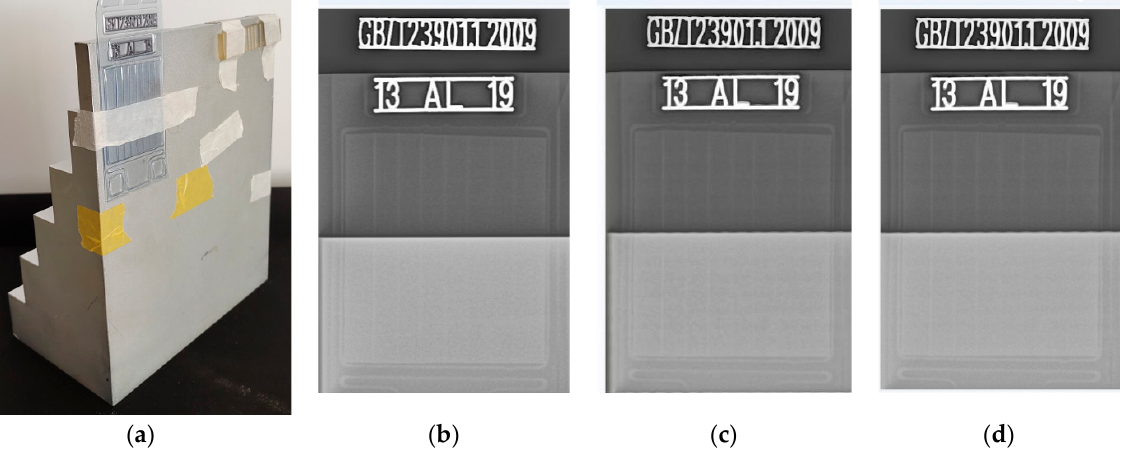
Figure 10. Test results of the contrast sensitivity: ( a ) experimental device, ( b ) original image, ( c ) 2 × 2 Sub-Pixel Shift Image, ( d ) 4 × 4 Sub-Pixel Shift Image.